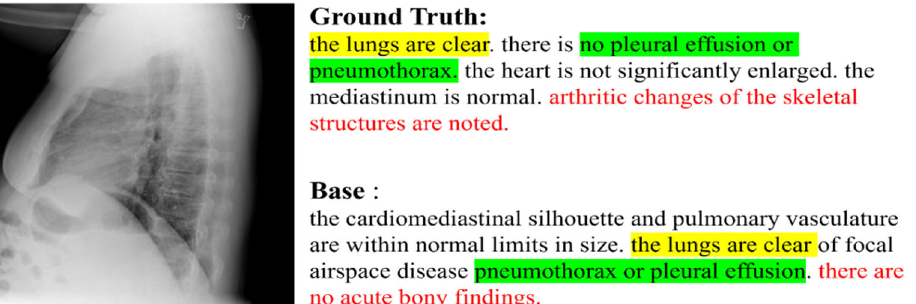
Figure 1. An example image and the caption generated from a baseline.